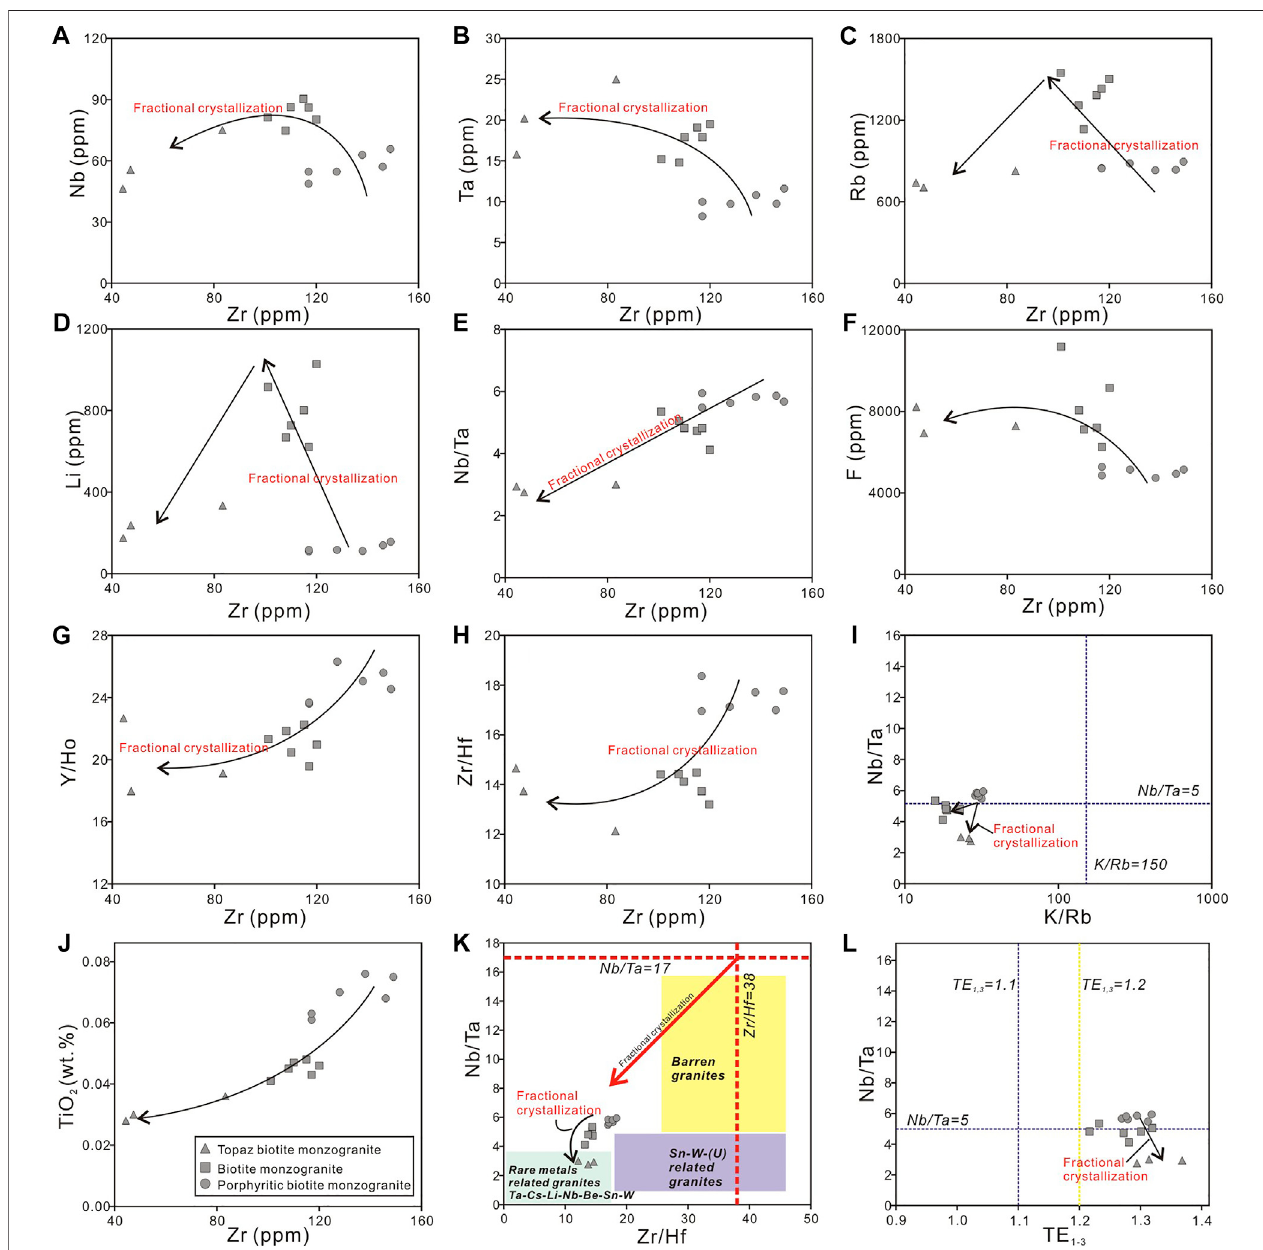
FIGURE 11 | Plots of Zr vs (A) Nb, (B) Ta, (C) Rb, (D) Li, (E) Nb/Ta, (F) F, (G) Y/Ho, (H) Zr/Hf, and (I) Nb/Ta vs K/Rb (J) Zr vs TiO 2 (K) Nb/Ta vs Zr/Hf (L) Nb/Ta vs